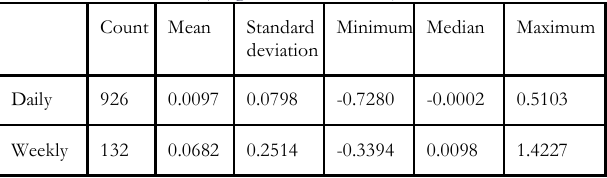
Table 3: Statistics summary for price returns of